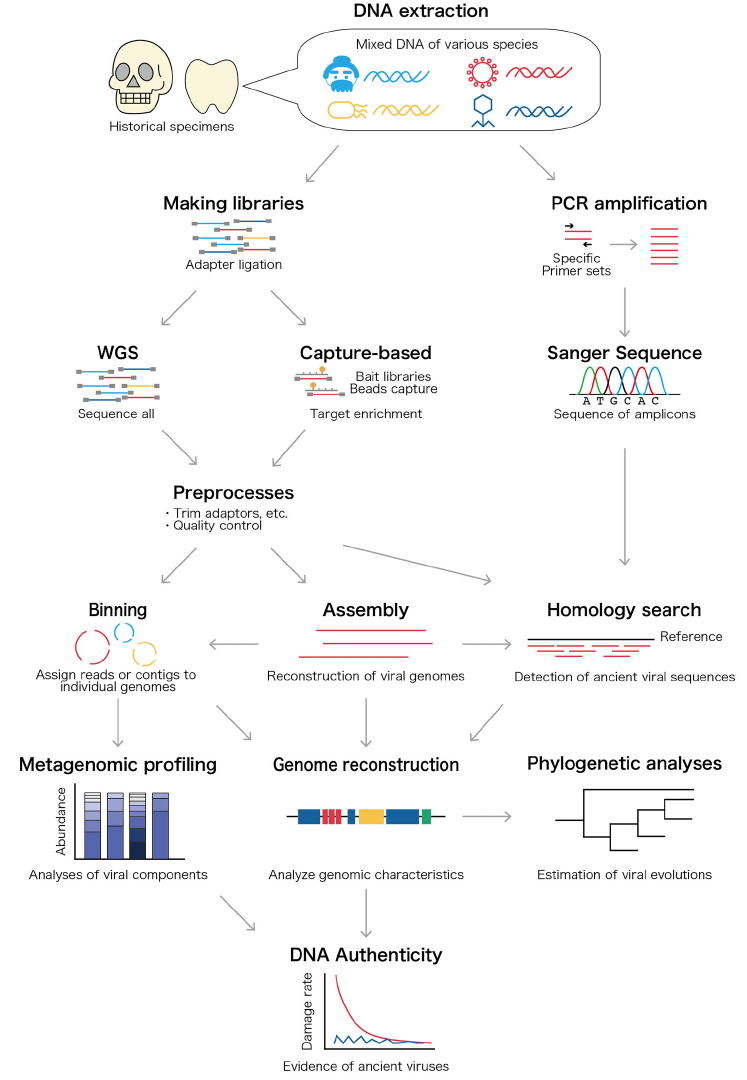
Figure 2. Overview of the experiments and bioinformatic analyses of ancient viral genomes. Ancient DNA can be extracted from historical specimens such as bones and teeth. The extracted DNA is derived from human, microbial, and viral genomes. Those mixed sequences can be determined by Sanger sequencing, whole genome sequencing (WGS), or capture-based sequencing based on next- generation sequencing (NGS) platforms. WGS can sequence untargeted DNA from humans, microbes, and viruses, and capture-based methods use biotinylated specific bait libraries and magnetic beads to enrich the target sequences. Following the preprocessing steps, contigs can be constructed by de novo assembly. Then, those contigs and preprocessed reads can be utilized for sequence binning to cluster the sequences into individual groups and obtain ancient viral sequences. Simultaneously, all contigs, preprocessed reads, and polymerase chain reaction (PCR) amplicons can be aligned to known viral sequences to detect candidate ancient viral sequences. Finally, the ancient viral sequences can be applied for downstream analyses: metagenomic profiling, the reconstruction of ancient viral genomes, DNA authenticity testing, and phylogenetic analyses.